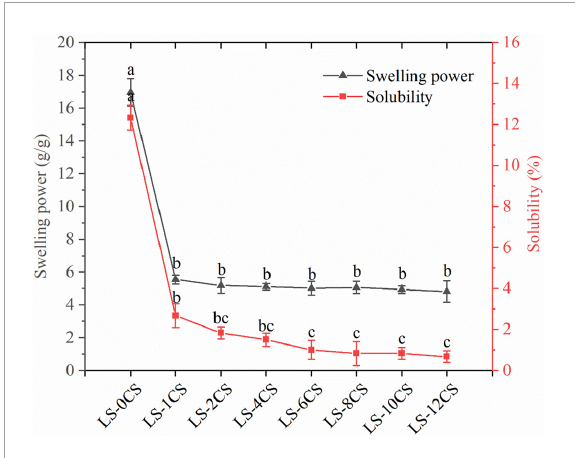
FIGURE7 Swelling powers and solubility levels of lotus seed cross-linked resistant starch samples. Different lowercase letters represent significant differences ( p <